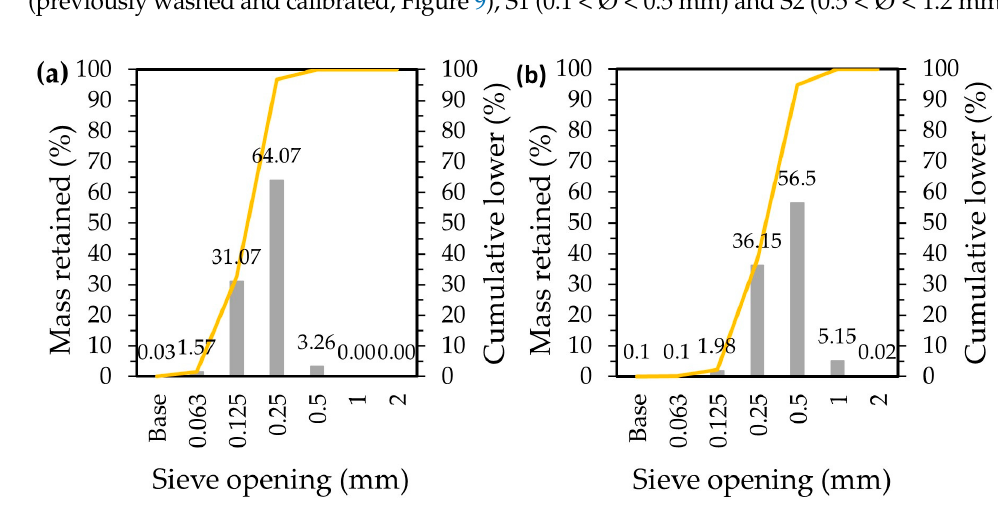
for the incorporation of a greater amount of residue or improve the properties of the cured specimens. The SG was ground in a planetary ball mill (Retsch PM100, Haan, Germany) until the whole sample passed through a 75 µm sieve (Retsch AS200, Haan, Germany) (GR_GS). The BFA samples were sieved at 2 mm (BFA1 and BFA2) and then subjected to two more pre-treatments. They were sieved at 63 µm (BFA1_S and BFA2_S) and also ground (Retsch PM100, Haan, Germany) until the whole sample passed through a 63 µm